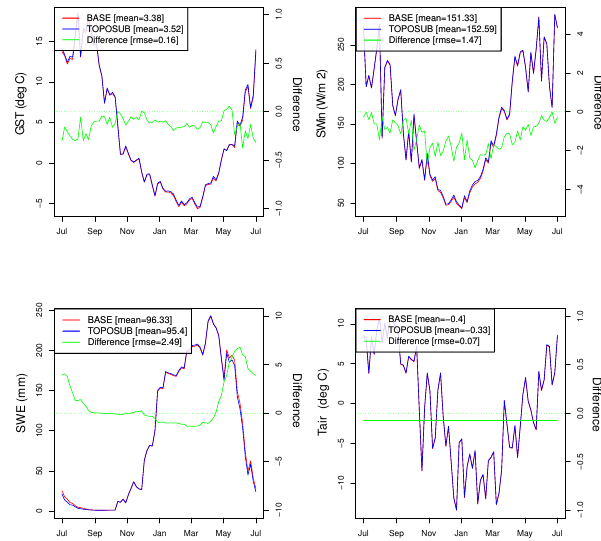
Fig. 12. Temporal characteristics of the mean domain values plot- ted at 5-day intervals for each target variable as simulated by BASE (red), TopoSUB (blue) and difference, BASE TopoSUB (green). Er- rors are relatively small in all cases. A stronger negative bias in SWin during winter months (approx. 2Wm − 2 ) and an increasing positive bias in SWE during the main snow melt months (April– June) up to